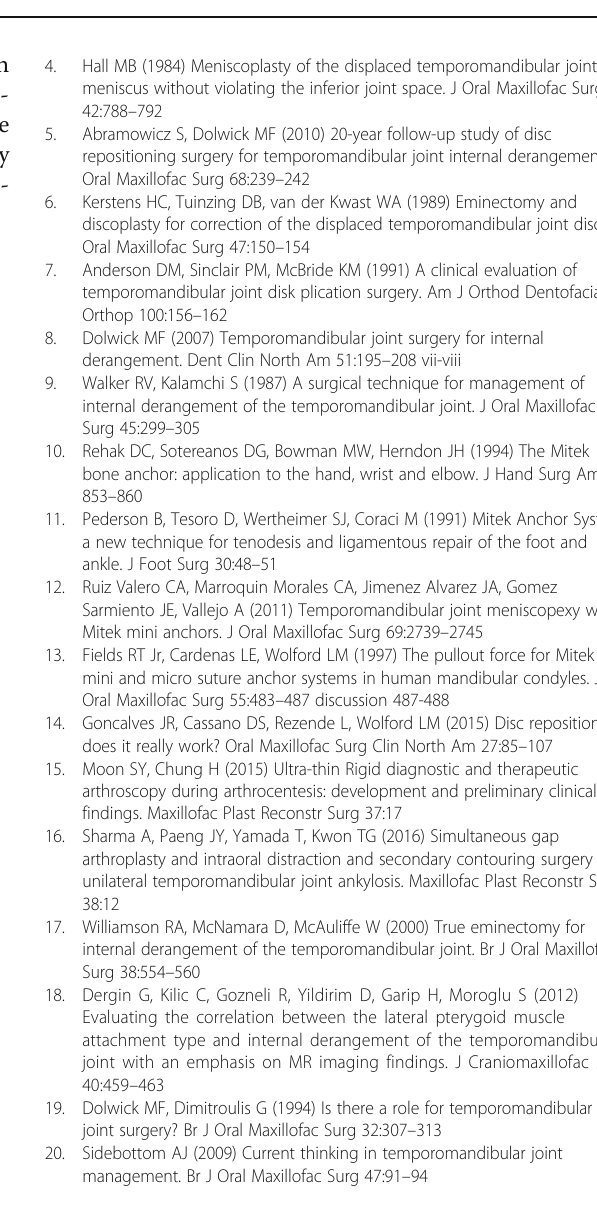
Fig. 14 a , b Pre- and postoperative (1 year) MRI of a female patient who underwent left joint disc plication surgery. The disc position is marked with an